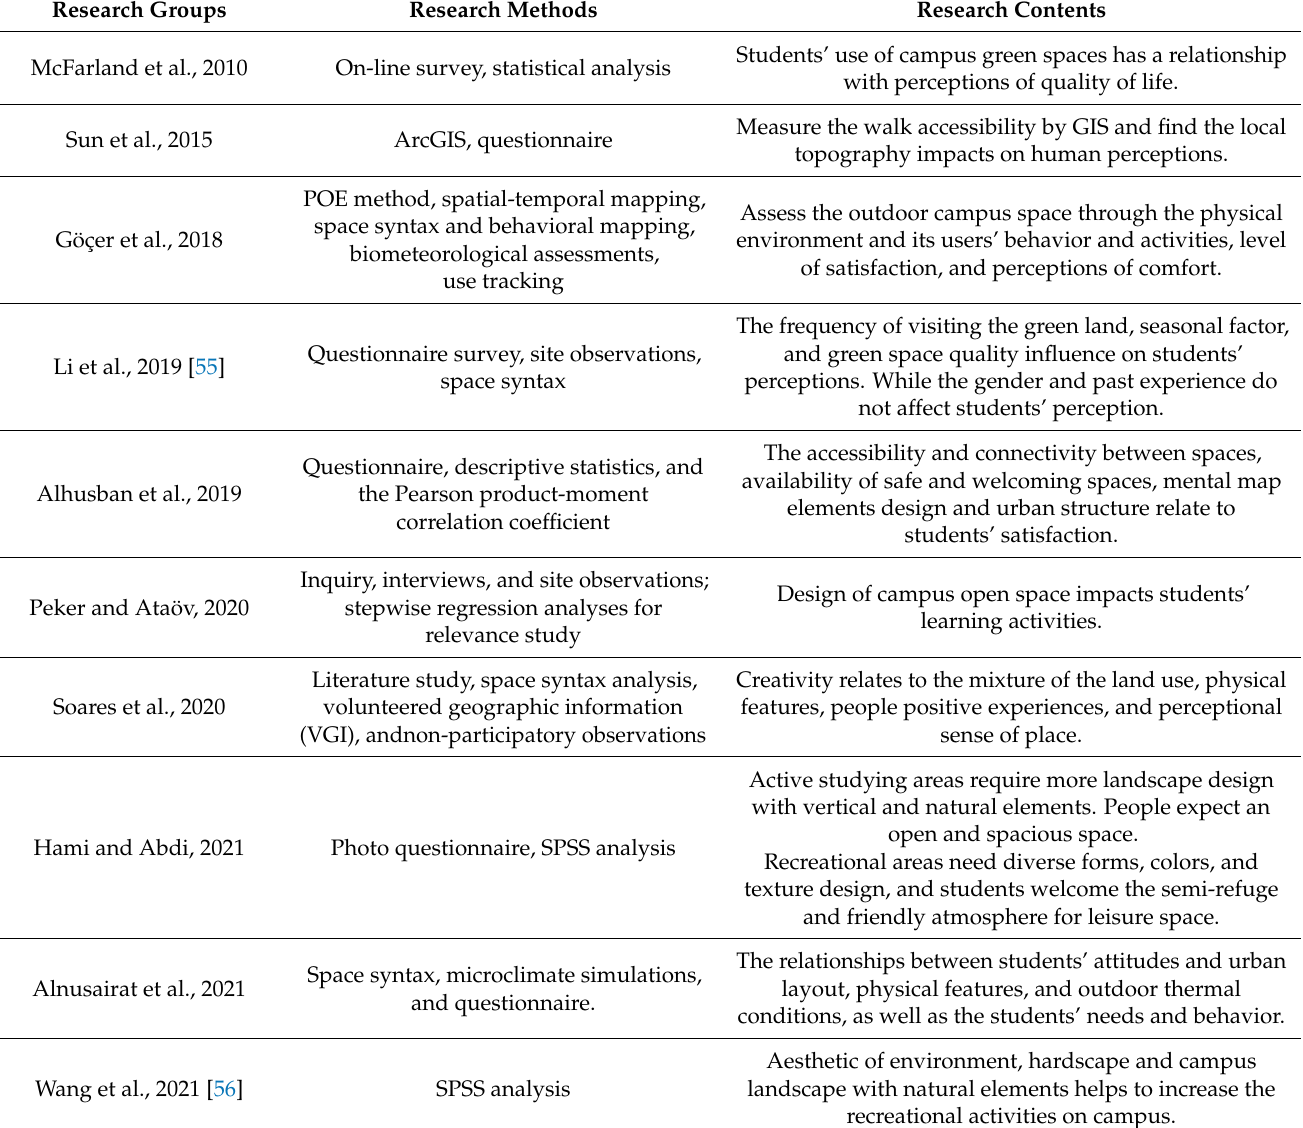
Table 2. Research methods of campus public space